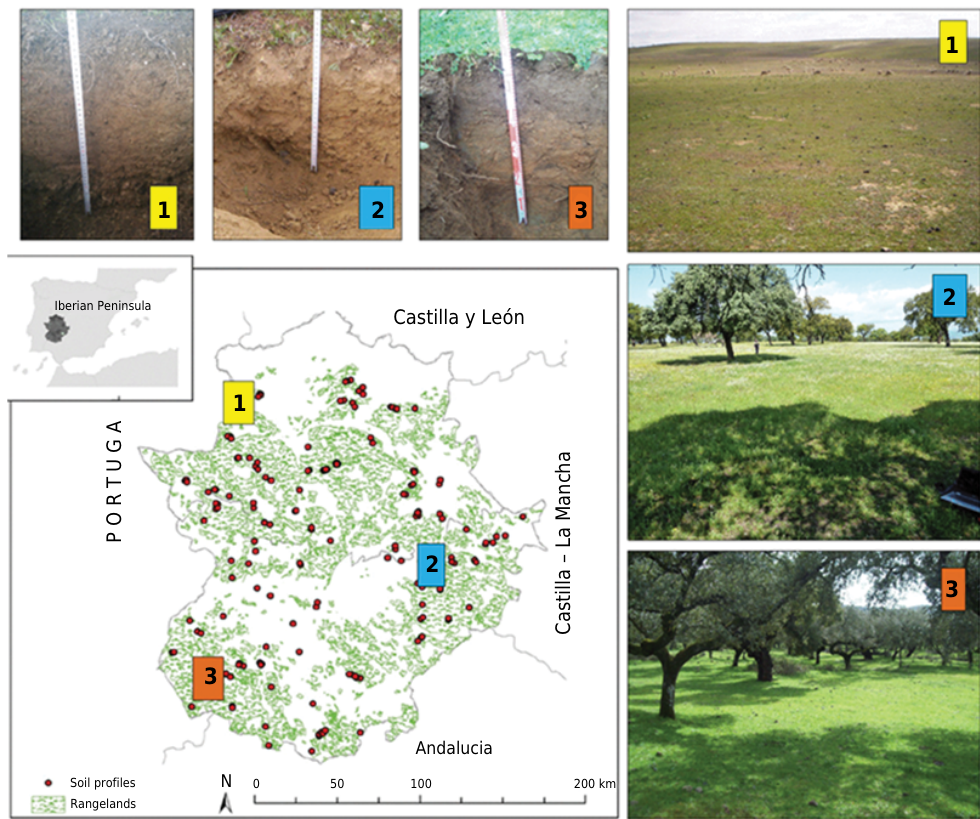
Figure 1. Geographical location of Extremadura and its soil profile description